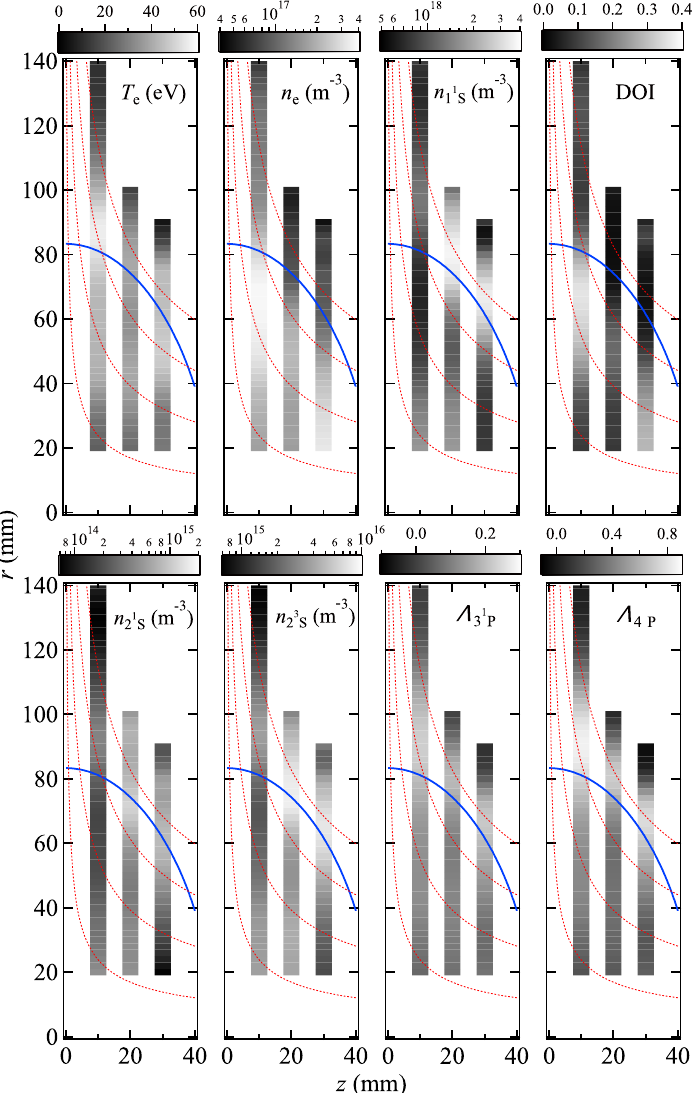
Figure 3. The rz -distributions of the plasma parameters, measured in a region designated by the black frame in Figure 2a. The solid blue line represents the ECR surface and the red dotted lines represent the magnetic field